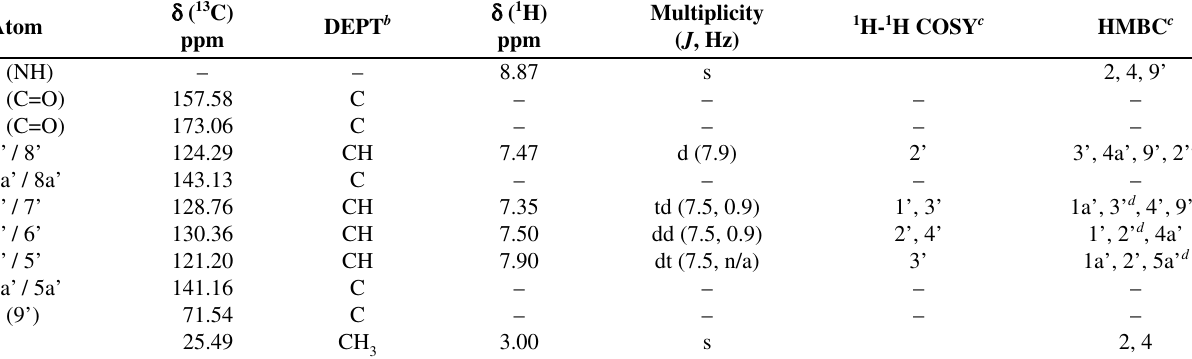
Table 1. 1 H and 13 C NMR spectral data and 1 H- 1 H COSY and HMBC correlations for 2 (600.13 MHz ( 1 H) and 150.903 MHz ( 13 C)) a , b